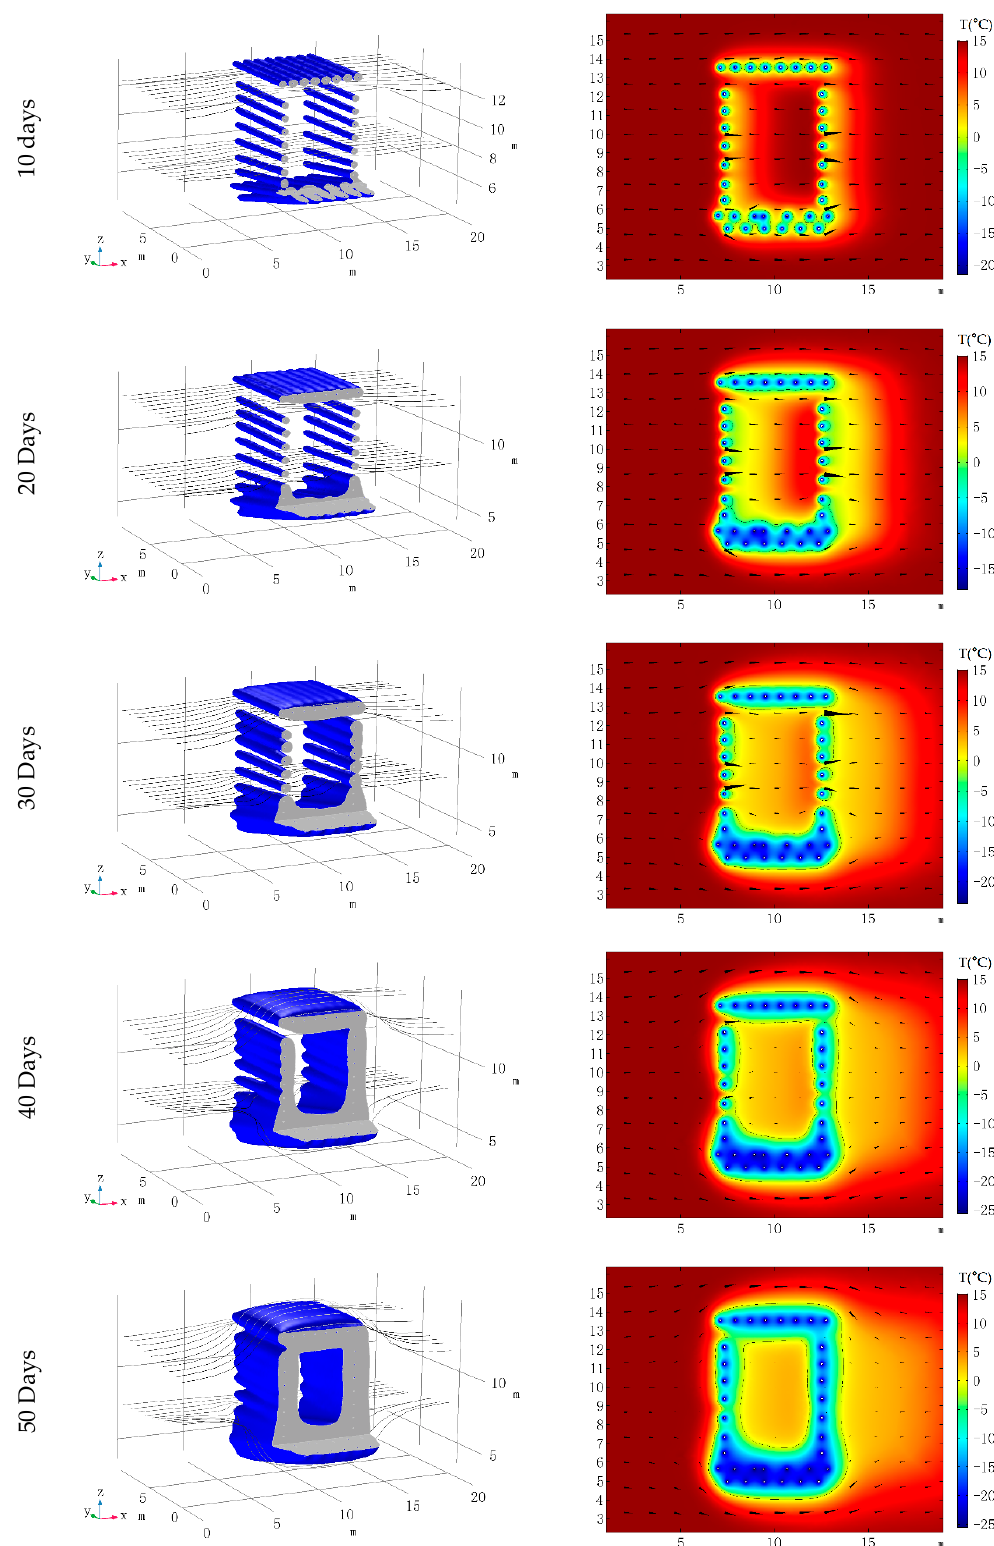
Figure 11. The development of freezing body with streamlines (black lines) ( left ) and temperature distribution with velocity vector (black arrows) at Y = 3.5 m ( right ) at various times.